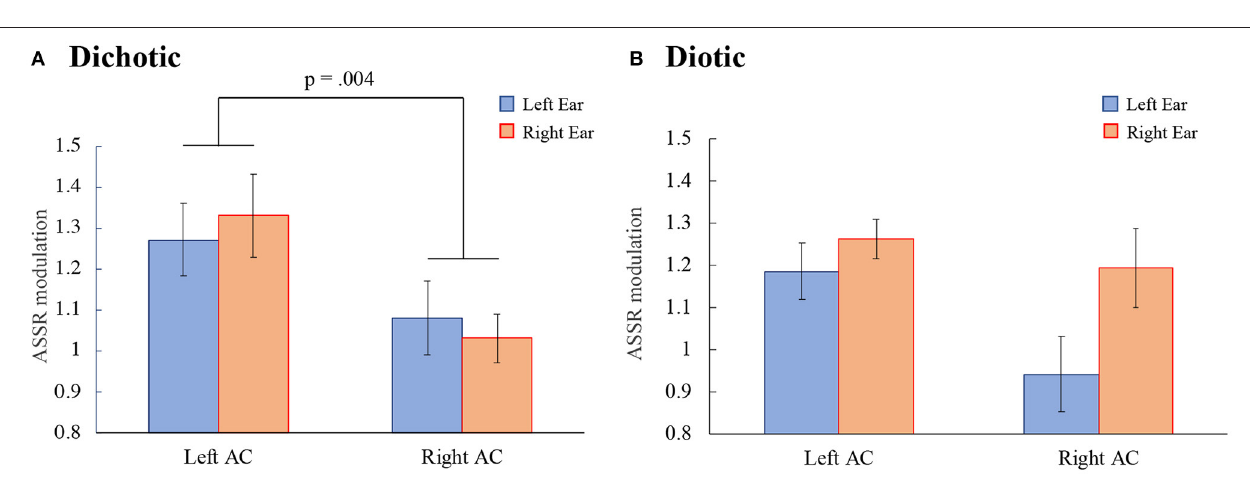
FIGURE 3 | Grand-mean values across 18 participants of the ASSR amplitude in the left and right auditory cortex (Left AC or Right AC) to the left and right-ears during the dichotic (A) and diotic (B) listening tasks. Error bars indicate standard error of the mean. ASSR, auditory steady-state response; AC, auditory cortex.